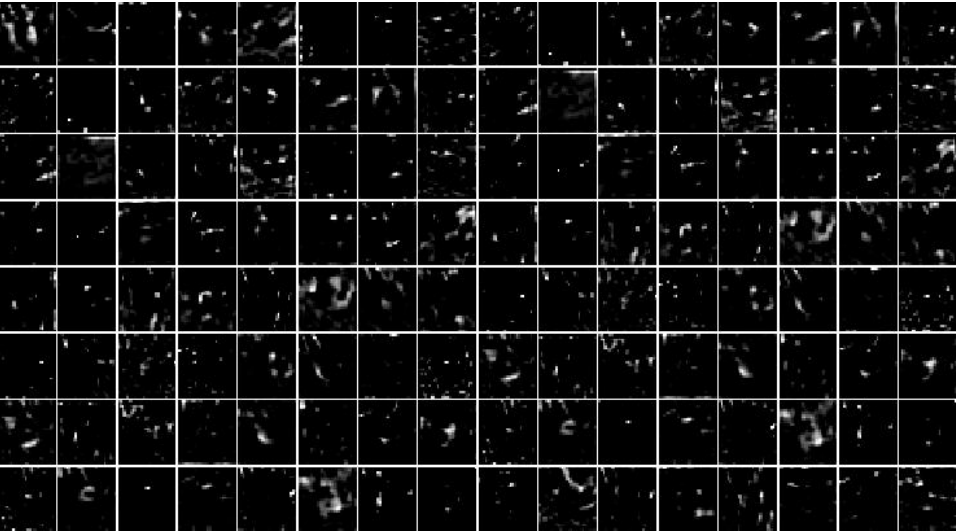
Figure 4. The first 128 channels of deep features from conv